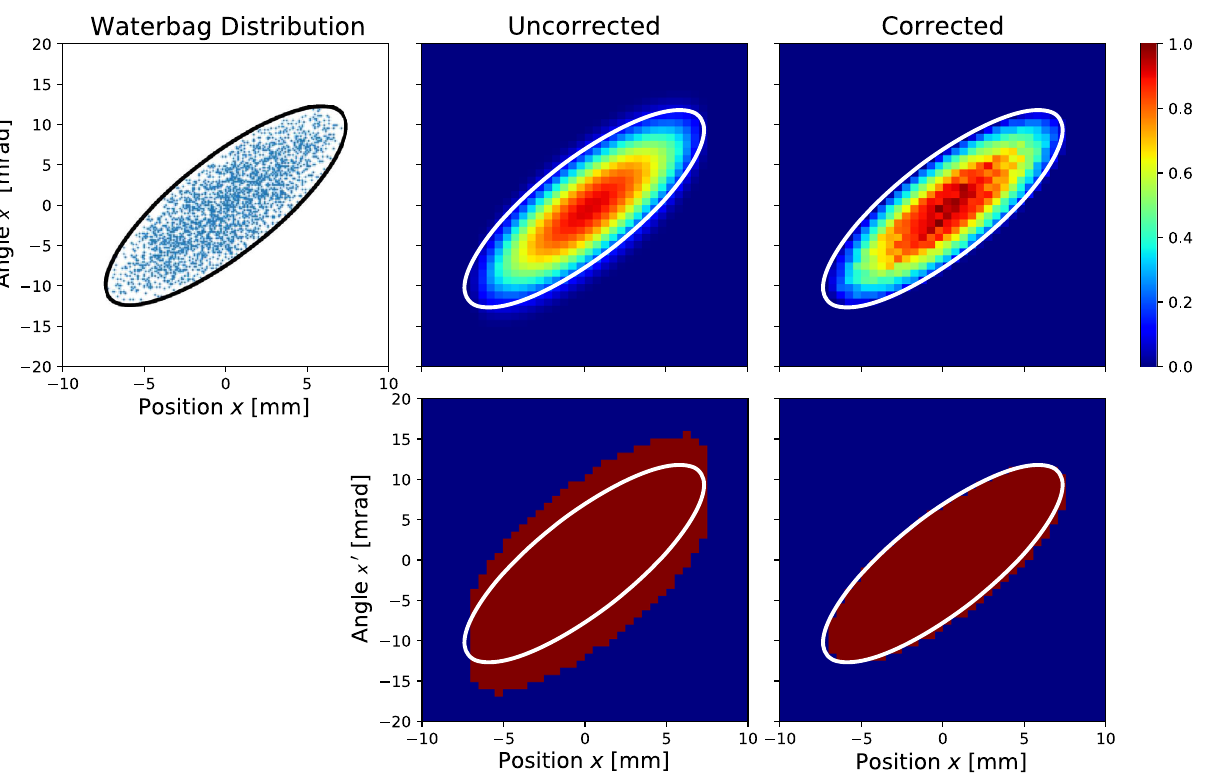
FIG. 9. Waterbag distribution (left column), compared against synthesized measurement data analyzed without (middle column) and with (right column) corrections for degenerate measurements. The upper row corresponds to intensity, whereas the lower row shows all nonzero intensity points in the same color to highlight extent errors. Black and white ellipses denote the ideal boundary of the waterbag distribution analyzed. In the left column sampled particles (1 out of 1000) are plotted. Measurement data are synthesized with s ¼ 300 μ m, and scanning step sizes of 0.5 mm and 10